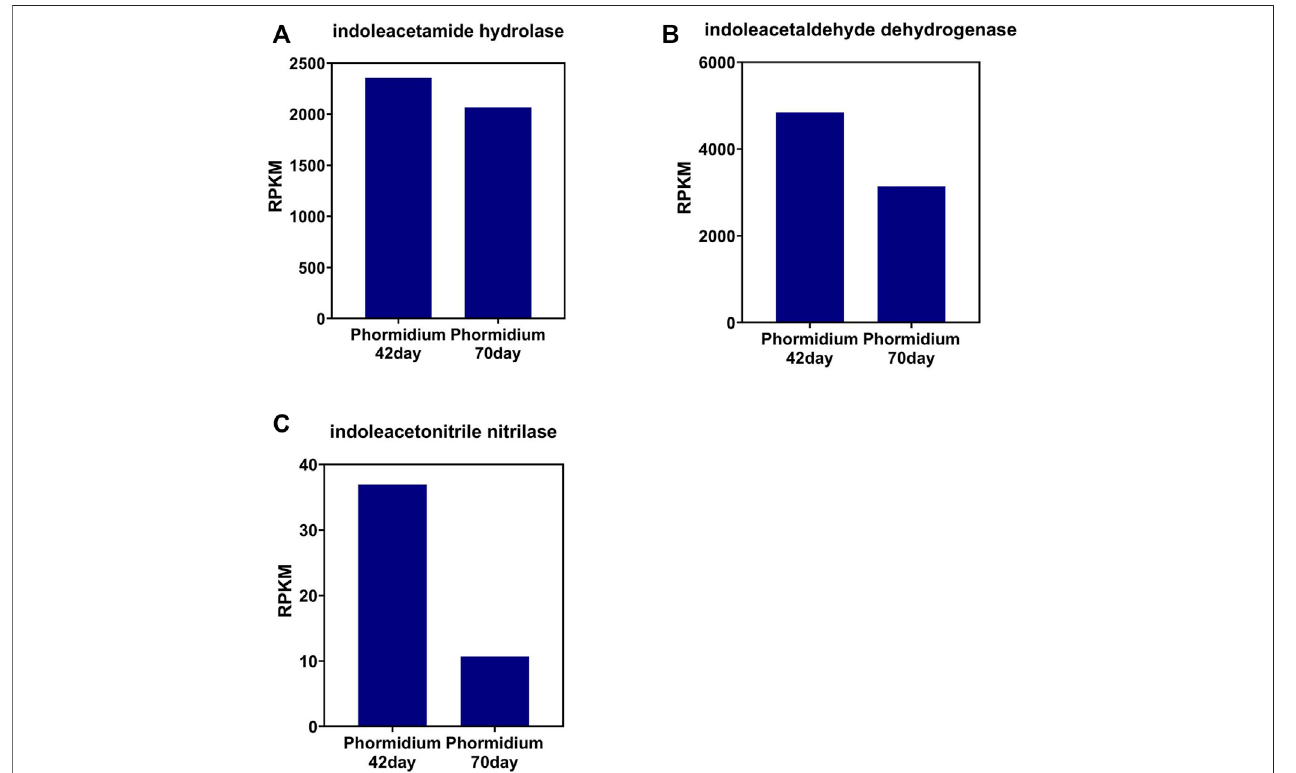
FIGURE 5 | Gene abundance of bacterial IAA synthetase in the Phormidium reactor. (A) Indoleacetamide hydrolase, (B) indoleacetaldehyde dehydrogenase, and (C) indoleacetonitrile nitrilase.